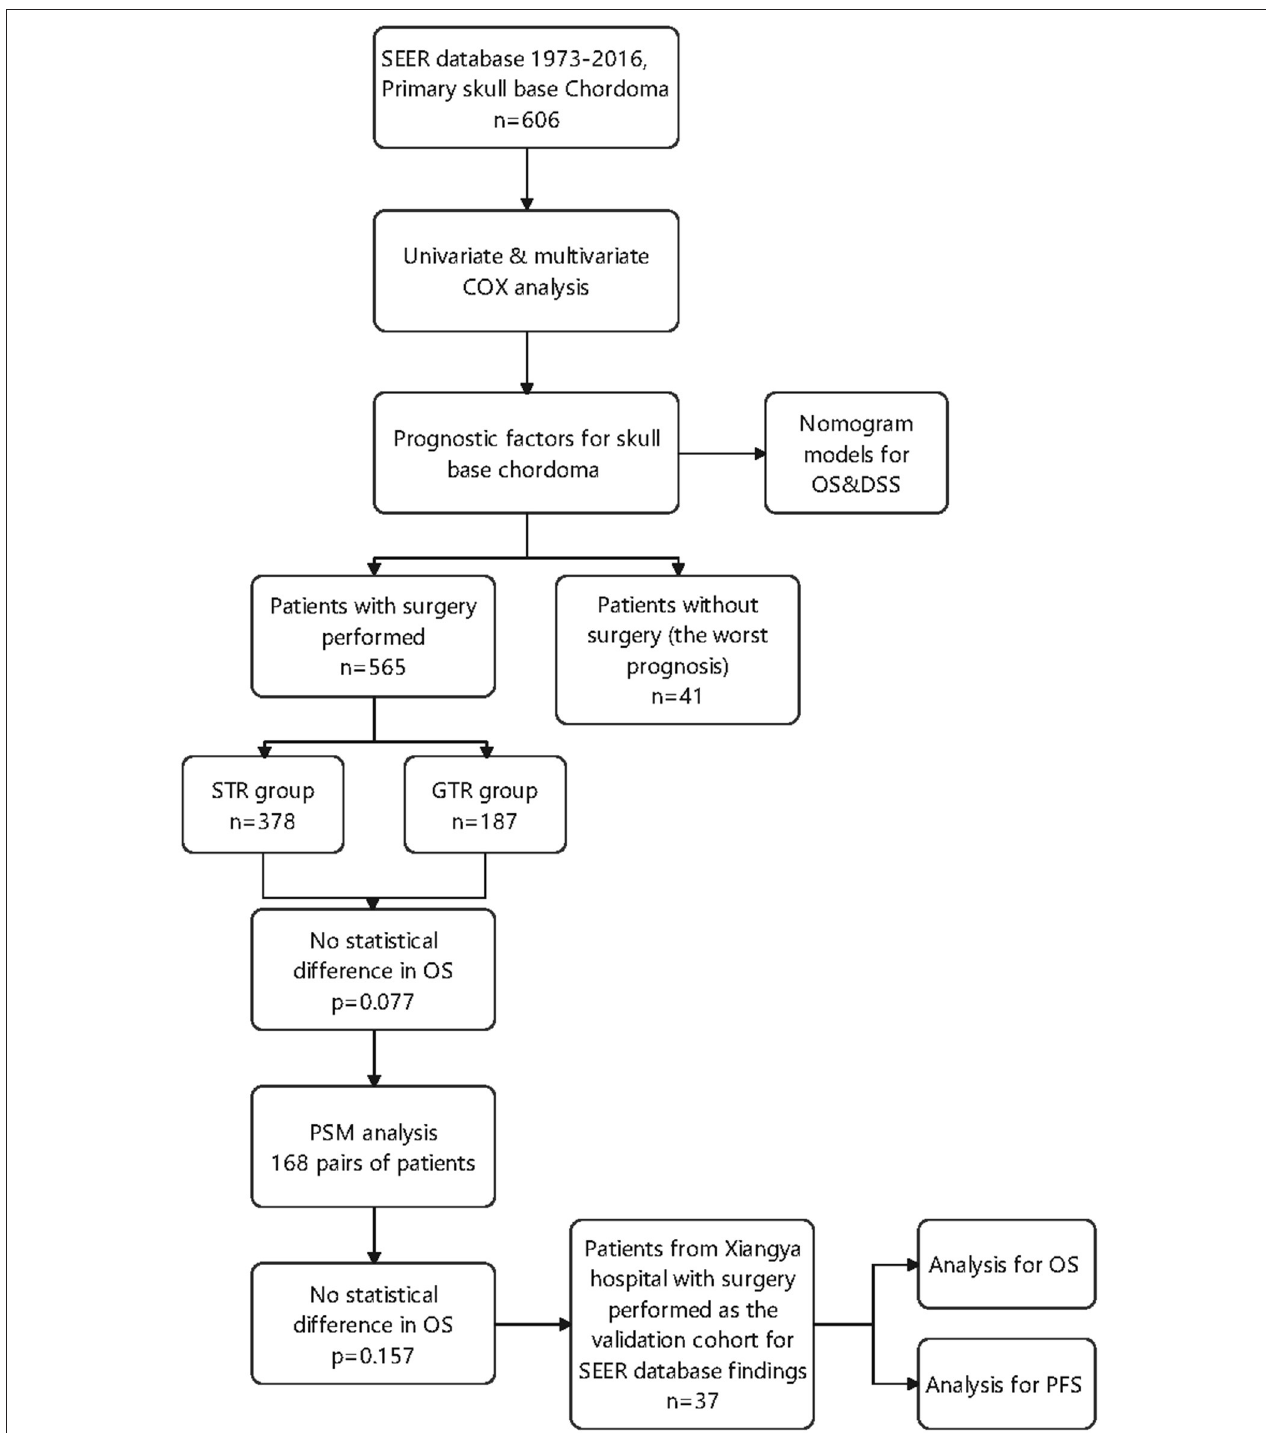
FIGURE 1 | The flow chart of data collection and analysis procedure in this study.